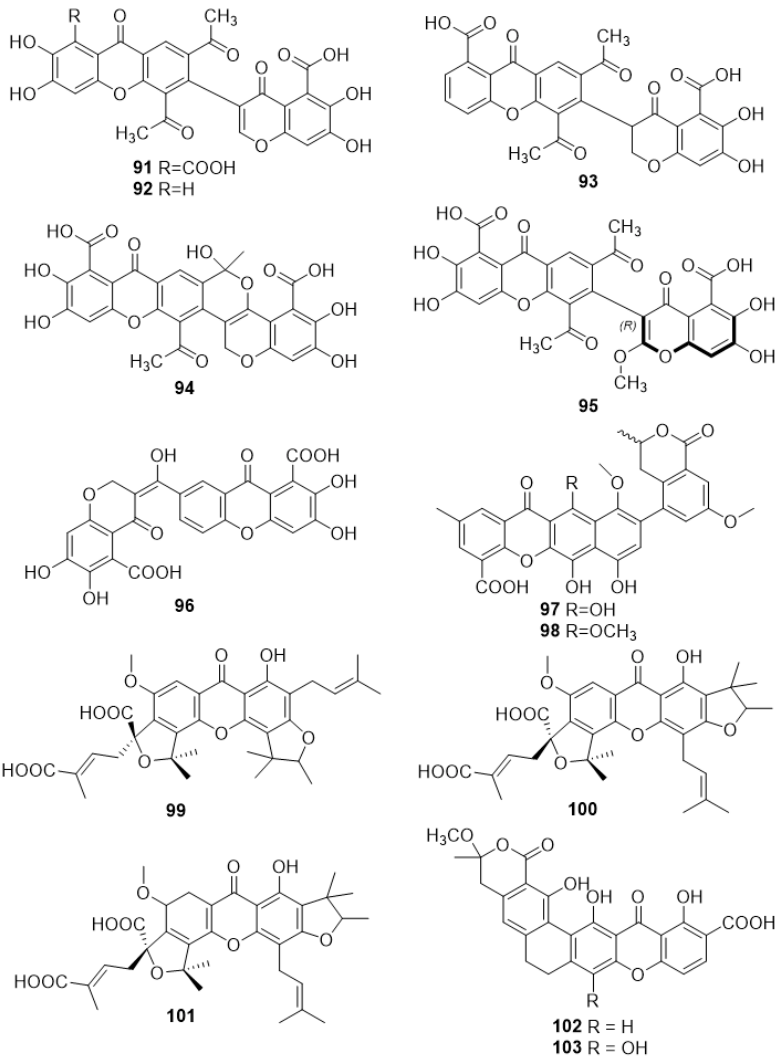
Figure 7. Structures of carboxyxanthone derivatives bound or fused to polysubstituted oxygenated heterocycles ( 91 – 103 ).